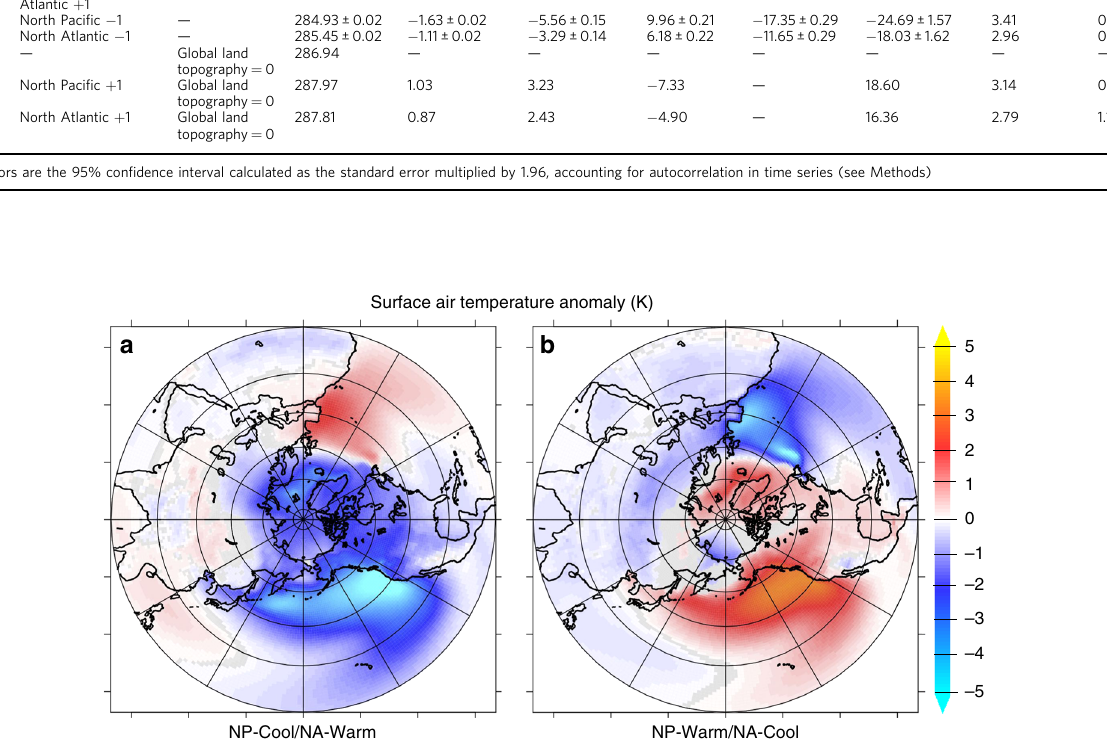
Fig. 2 Surface air temperature anomalies in the zonally redistributed heat fl ux simulations. The NP-Cool/NA-Warm simulation ( a ) prescribes a negative heat fl ux perturbation in North Paci fi c ( − 1 W/m 2 global) compensated with an equivalent positive North Atlantic Q- fl ux perturbation ( + 1 W/m 2 global),